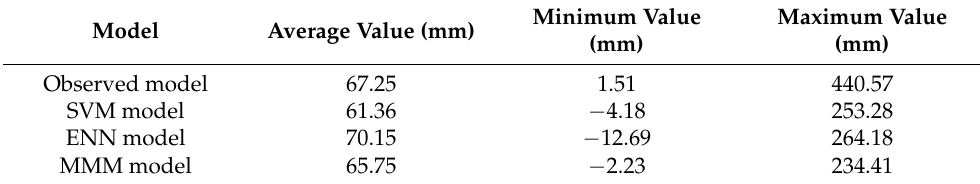
Figure 6. Prediction results of SVM model, ENN model, and MMM model. Table 1. Monthly runoff characteristic values.